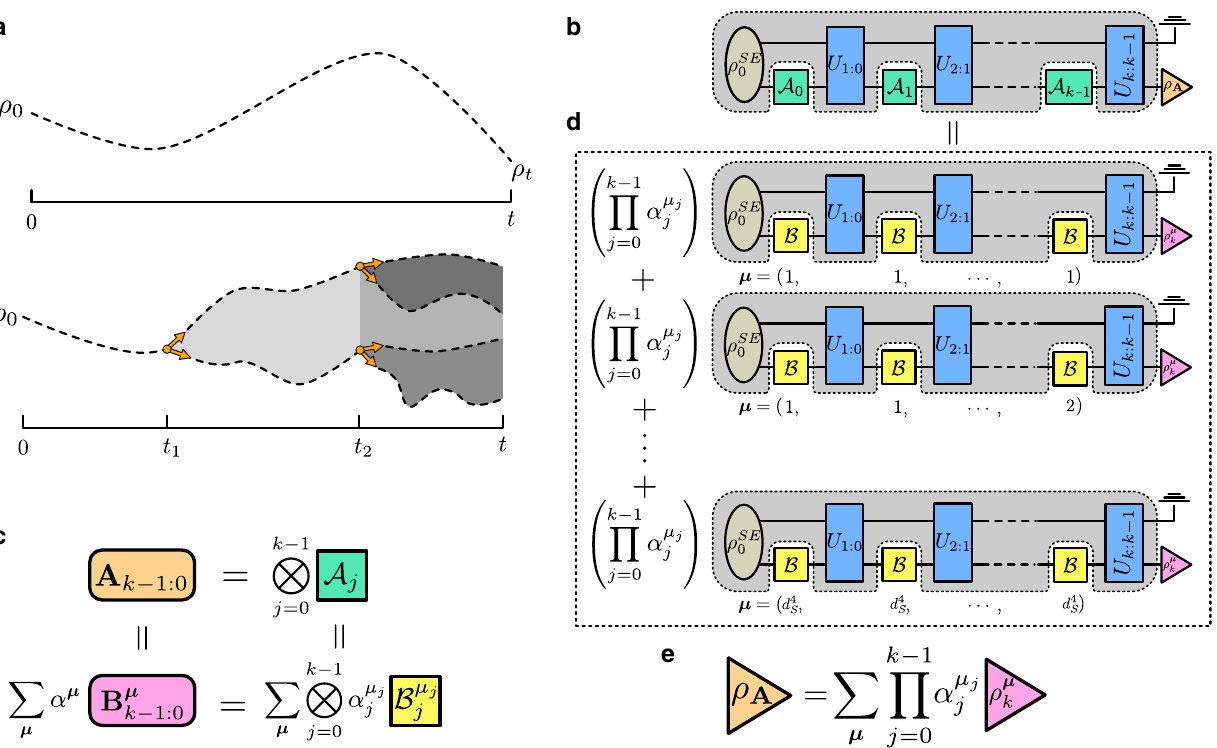
Fig. 1 An illustrative summary of process characterisation. a The state of an open system over time follows a trajectory through state space until some fi nal time at which the state is probed (top). By applying control operations at times t t 1 and 2 , an experimenter can anchor and change the trajectory, which can be inferred via a linear combination of trajectories corresponding to basis operations (bottom). b A circuit model showing a sequence of operations f A j g interleaved with SE interactions, resulting in a fi nal state ρ A . c A sequence of operations A k − 1:0 can be expressed as a tensor product of